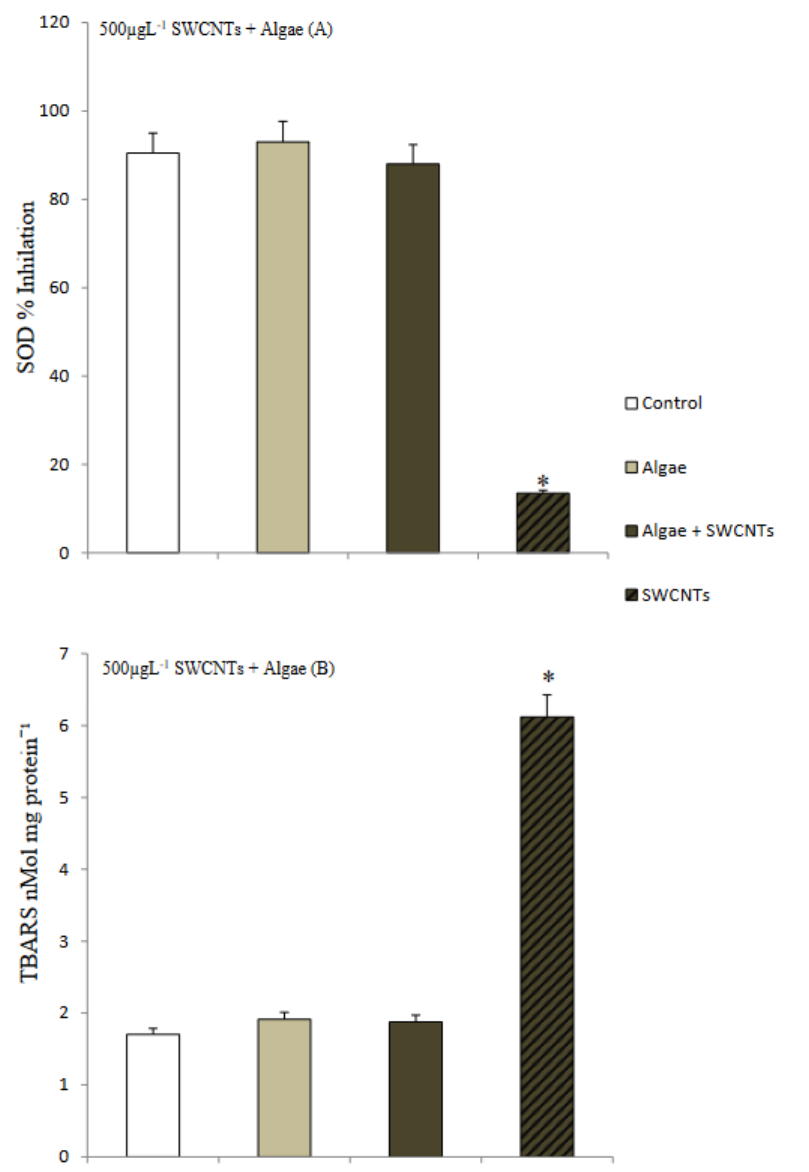
Figure 14. Oxidative stress in mussel gill tissue after feeding on algae ( Tetraselmis suecica ), SWCNT 500 µ g L − 1 alone and Tetraselmis suecica + SWCNTs 500 µ g L − 1 for 24 h. ( A ) Superoxide dismutase (SOD) activity (One Way ANOVA: F = 6.7, df num = 3, means ± SD; n = 3; p < 0.001); ( B ) Lipidperoxidation (TBARS); * significantly different from control, algae and algae + SWCNTs 500 µ g L − 1 (One Way ANOVA: F = 5.8 df num = 3, means ± SD; n = 3; p < 0.001).